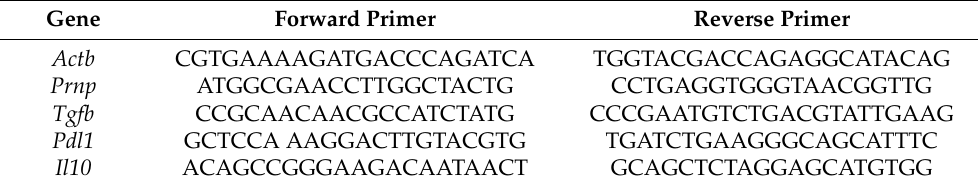
Table 1. List of primer sequences for quantitative PCR